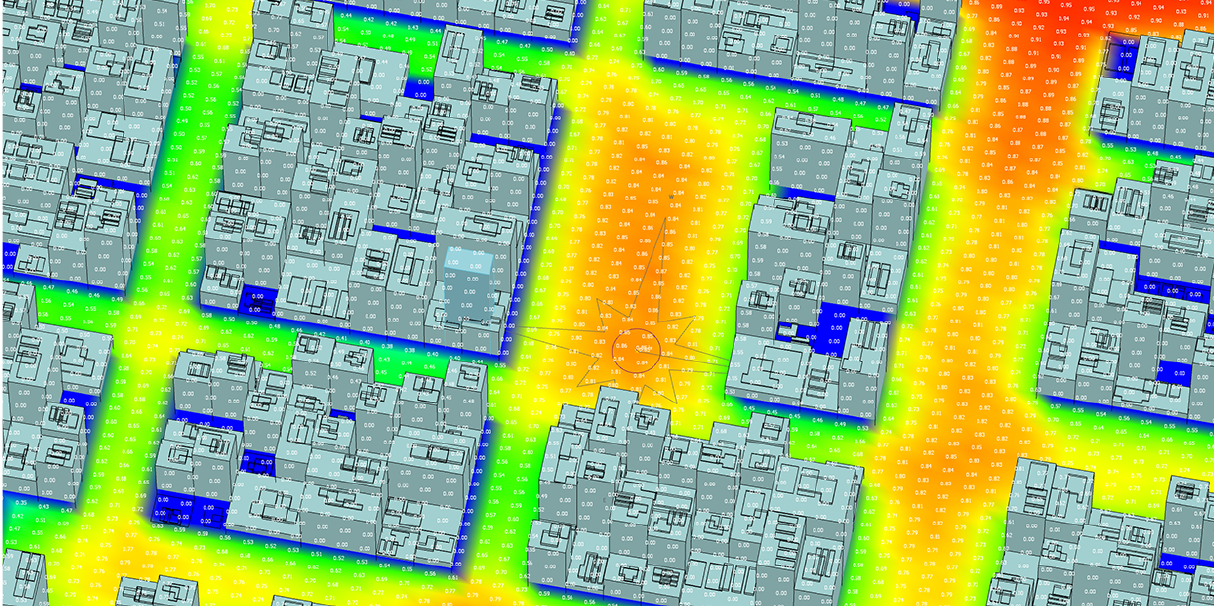
Figure 3. This figure shows a screen grab of the grid of lux meters configured to read SVF levels for a large urban precinct.